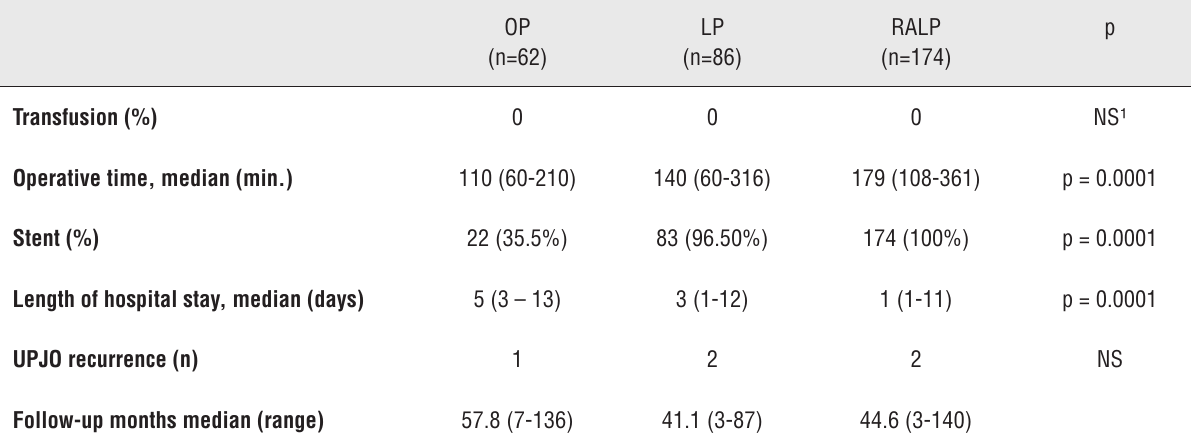
Table 2 - Surgery outcomes and complications’ rate of patients submitted to open, laparoscopic and robotic